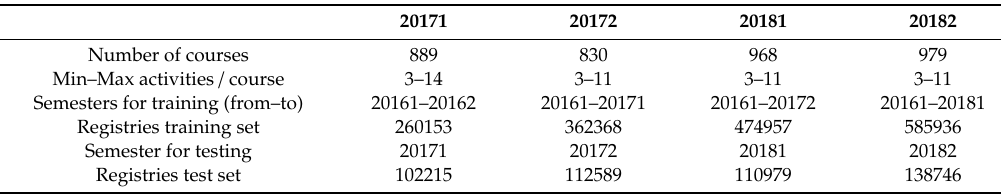
Table 2. Description of the